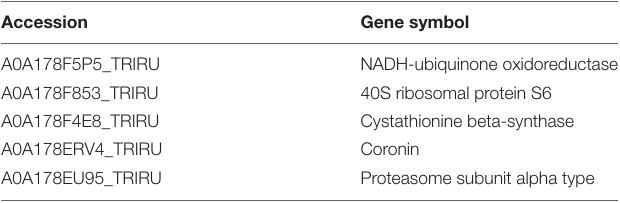
TABLE 3 | The list of top 5 down-regulation proteins between 256 µ g/mL group and control group.